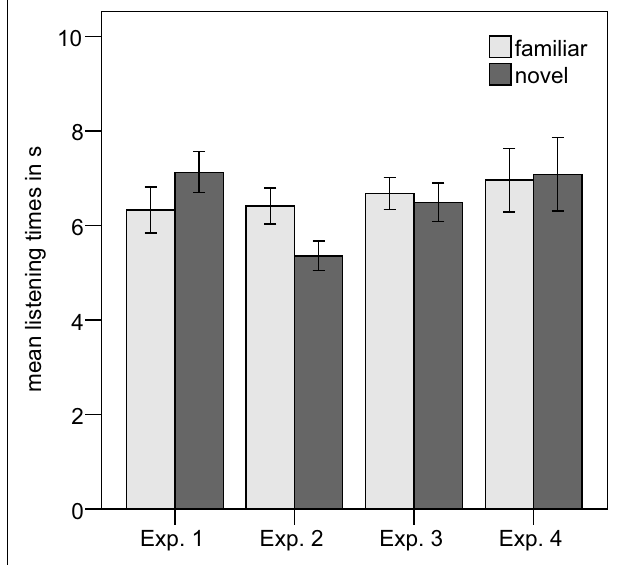
FIGURE 2 | Mean listening times for Experiment 1–4. Error bars indicate ± 1